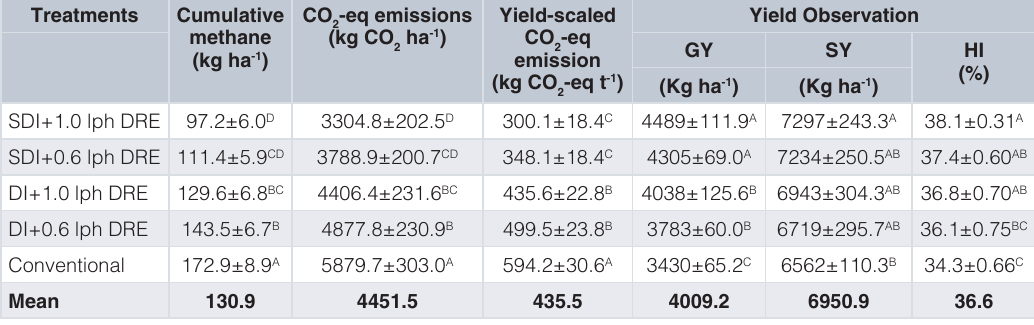
Table 3. Effect of drip system on cumulative methane, CO and rice yield. Numbers in the table represent means ± standard deviation (n =3). Letters indicate significant differences (P<0.05) among means according to an ANOVA.